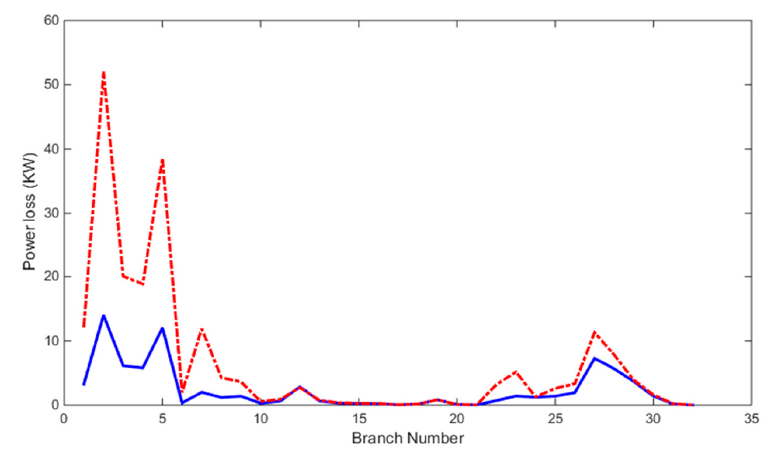
Figure 8. Characteristics of power loss at unity pf.